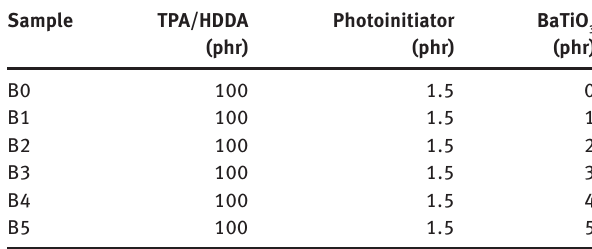
Table 1: Formulation of photopolymer/BaTiO